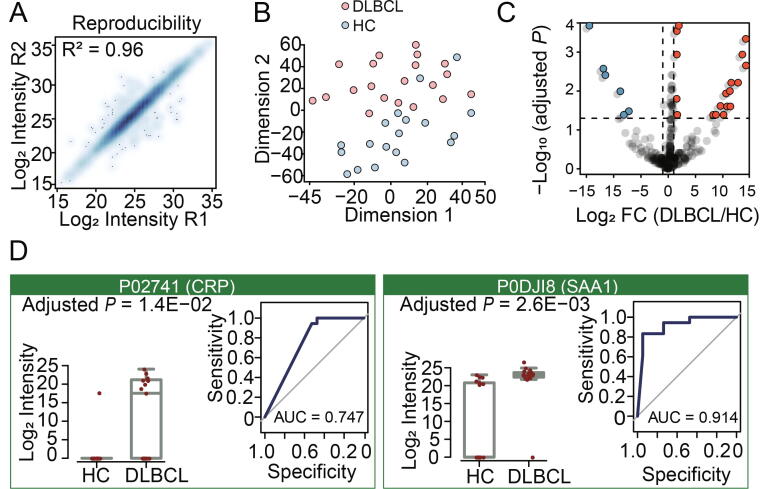
DIA analysis of plasma samples from DLBCL patients and HC subjectsA. Technical reproducibility for protein quantification of four plasma samples from two DLBCL patients and two healthy control subjects. B. 2D plane t-SNE plot showing that proteomes are separated. C. Volcano plot showing significantly down-regulated (blue) and up-regulated (red) proteins in 37 plasma samples (19 samples from DLBCL patients and 18 samples from HC subjects). D. The relative protein expression as calculated by MS intensity for CRP and SAA1. P values adjusted with Benjamini & Hochberg are shown under each protein name Left: Boxplot and ROC curve of CRP. Right: Boxplot and ROC curve of SAA1. DLBCL, diffuse large B cell lymphoma; HC, healthy control; CRP, C-reactive protein, UniProtKB: P02741; SAA1, serum amyloid A1, UniProtKB: P0DJI8.